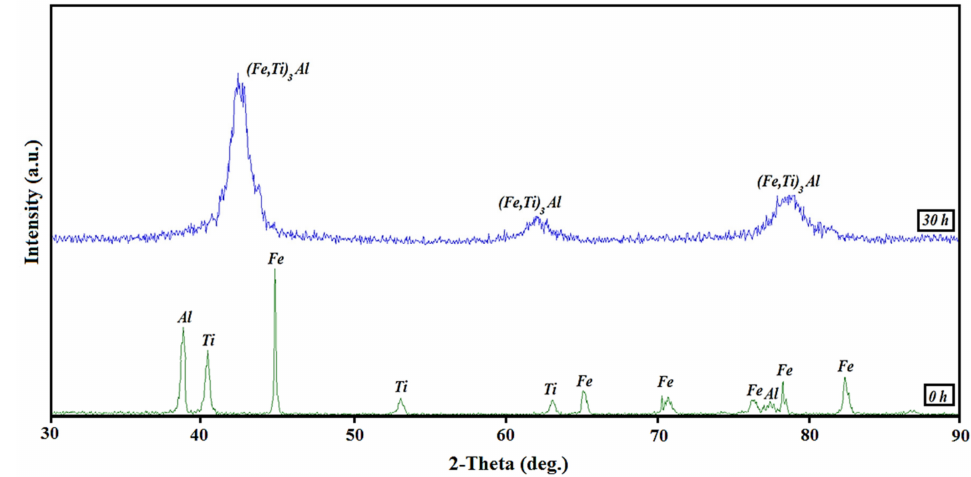
Figure 3. XRD analysis of Fe 50 Al 25 Ti 25 powder mixtures before and after mechanical